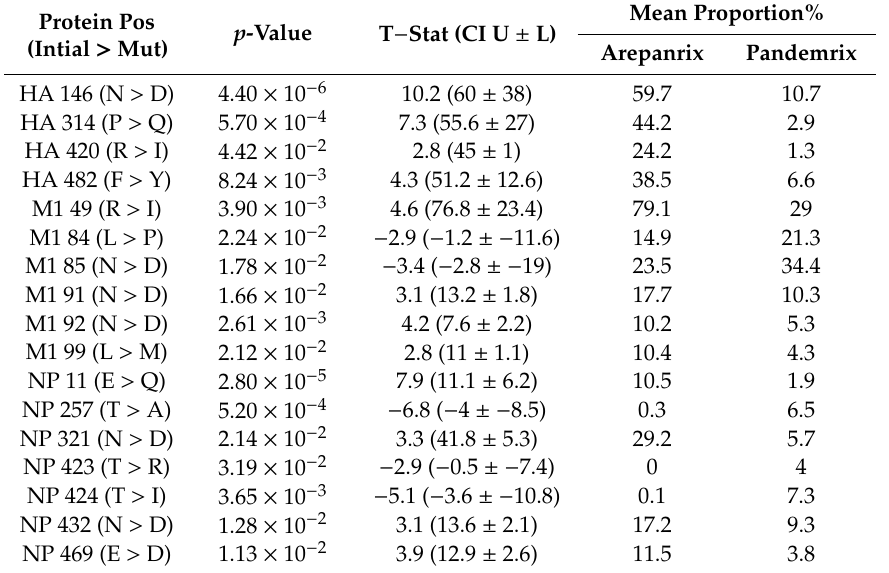
and five batches of Arepanrix ®